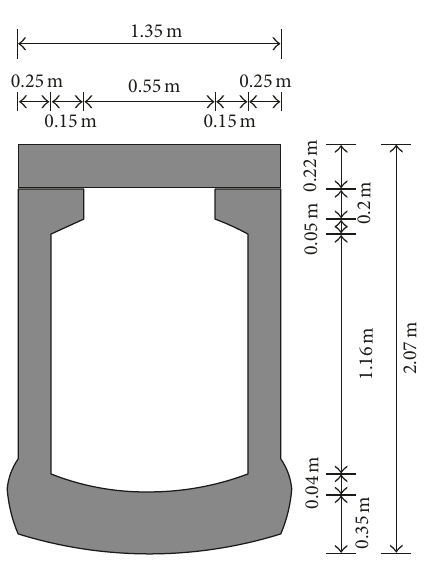
Figure 7: Cross-section of the U-shaped prestressed concrete guideway girder at the Incheon Airport Maglev Railway.